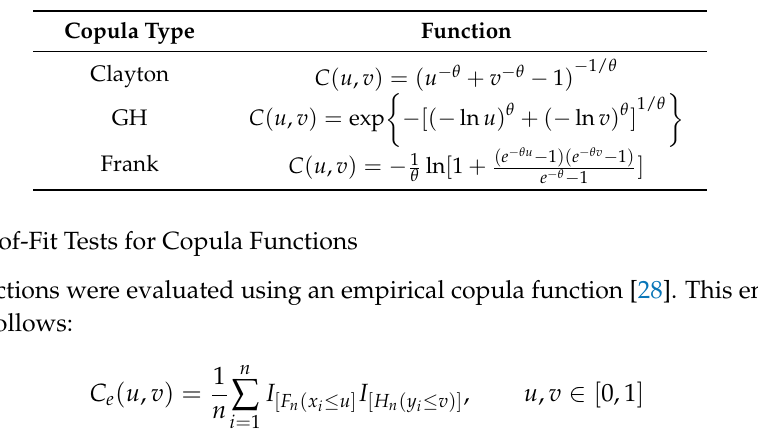
Table 2. Formulas of various copulas and their parameter estimation.